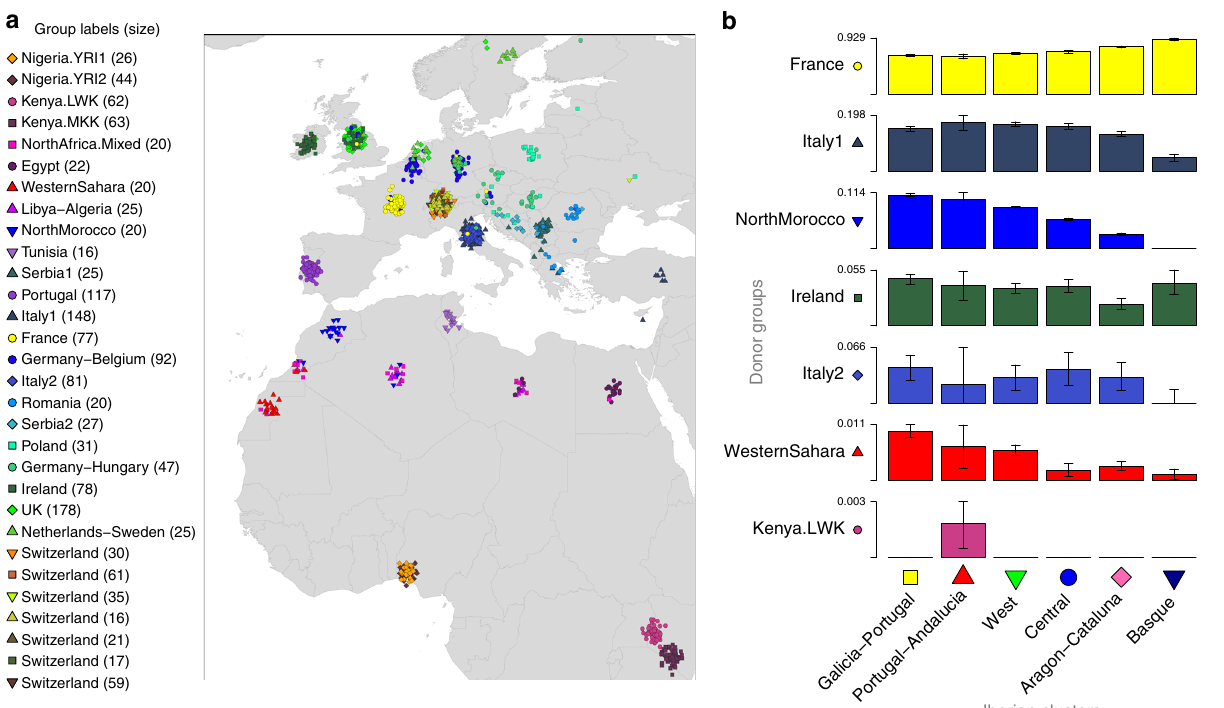
Fig. 6 Locations of donor groups and ancestry pro fi les of Iberian clusters. a Locations of individuals ( n = 1503) within 30 non-Spanish genetic groups inferred using fi neSTRUCTURE (Methods). Each point represents an individual, placed at their country-level location of origin, and coloured according to their inferred genetic group. Individuals from the same location (country) have been randomly jittered for visual clarity. Names are assigned to clusters based on where the majority of the individuals in the clusters are located. Where a cluster was split more evenly across two regions, a double-barrel name is used. All groups shown here, except ‘ Portugal ’ , were used as donor groups in the analyses of Iberia. b Each column shows the ancestry pro fi le for each of the inferred clusters shown in Fig. 5a. The heights of the bars show the proportion of each cluster ’ s ancestry which is best represented by that of the labelled non-Iberian donor group (Methods). Note that each row has a different y -axis range for visibility of the smaller components. Error bars show the range of the inner 95% of 1000 bootstrap resamples (Methods), and donor groups are only shown if at least one cluster has a range not including zero and a point estimate >0.001. The exact values plotted here and cluster sample sizes are in Supplementary Table